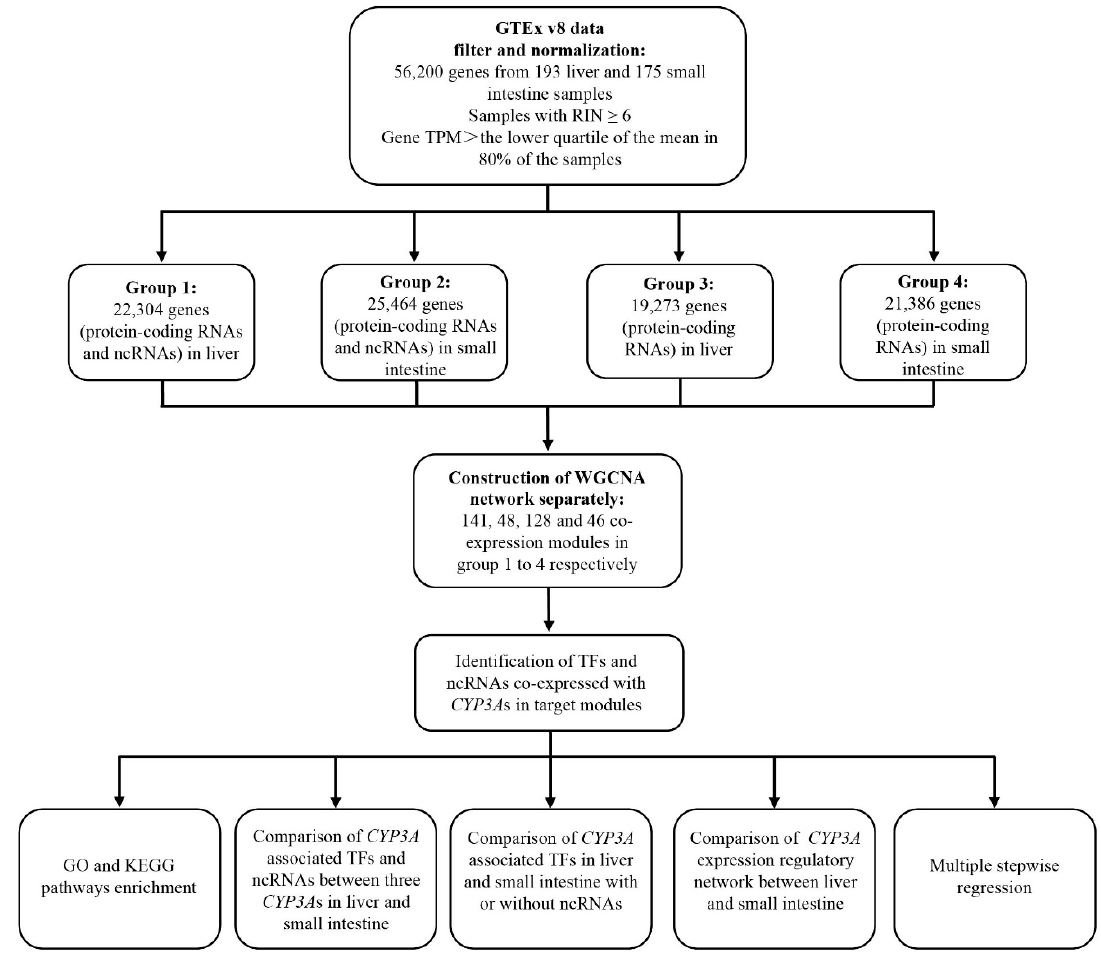
Figure 1. Study design. GTEx: Genotype-Tissue Expression project. RIN: RNA integrity number. TPM: transcripts per million. WGCNA: weighted gene co-expression network analysis. TFs: transcription factors. NcRNAs: non-coding RNAs.